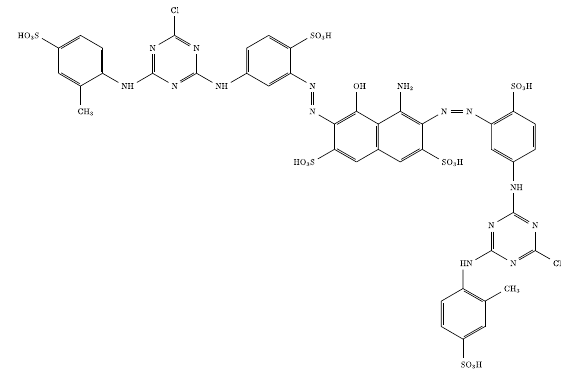
Figure 10. Chemical structure CAS No. 186554-26-7.